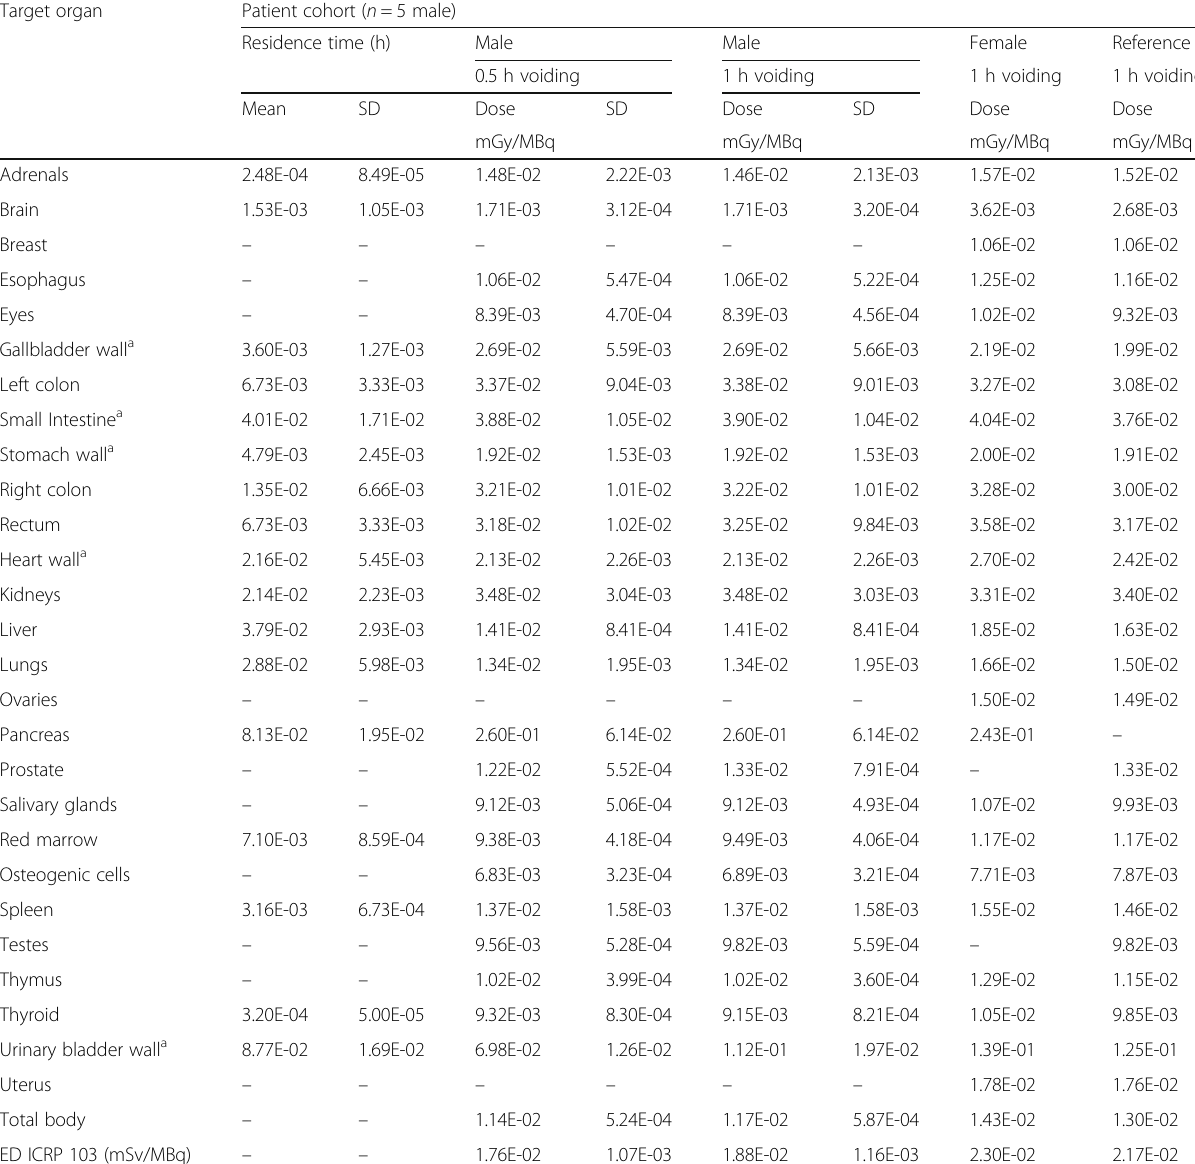
Table 2 Residence times, organ-absorbed doses and ED according to OLINDA/EXM 2.0 for 30-min and 1-h urinary voiding cycles in men. Extrapolated organ-absorbed doses in female and reference person are reported for 1-h urinary voiding cycle only Target